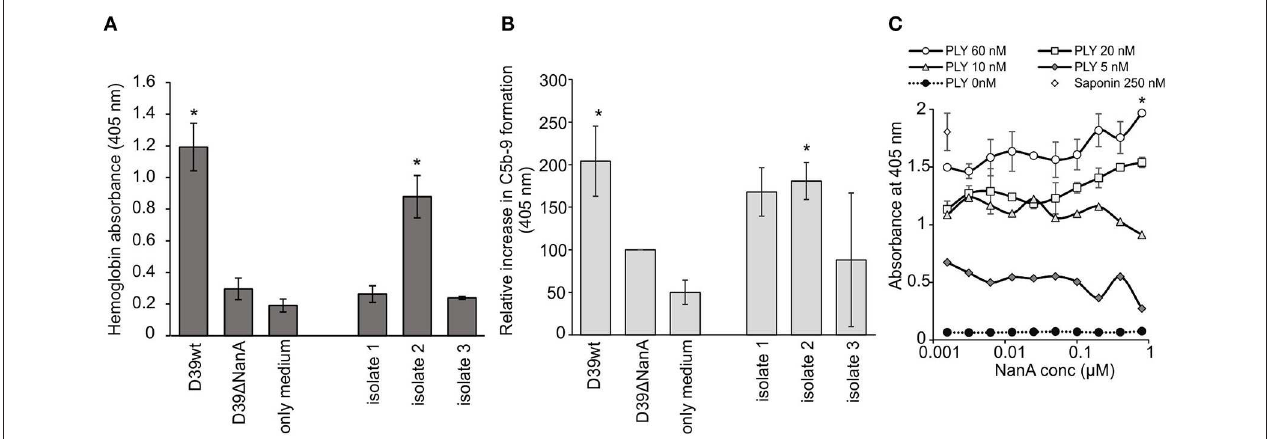
FIGURE 5 | Effect of S. pneumoniae NanA expression on complement-mediated red blood cell lysis. (A) Hirudin-anticoagulated whole blood was incubated for 1h at 37 ◦ C with the supernatants from S. pneumoniae D39 wild type (D39 wt), D39 nanA deletion mutant (D39 1 NanA) and three clinical isolates (isolates 1–3). Hemolysis was determined by measuring absorbance of hemoglobin at 405nm from the plasma ( n = 3). (B) Complement activation in whole blood was determined by measuring the formation of soluble SC5b-9 from blood isolated plasma by EIA (450nm) ( n = 3). All values are shown as a percentage of A450 values relative to D39 nanA mutant strain. Increase in SC5b-9 is calculated as relative absorbance against D39 1 NanA supernatant treated blood that was 0.500 ± 0.150 at 450nm in the isolated plasma. (C) Effect of NanA on hemolysis caused by pneumolysin (PLY). Red blood cells were incubated with increasing concentration of NanA compared with specific PLY concentration (0, 5, 10, 20, or 60nM). Hemolysis was detected by measuring absorbance of the supernatant at 405nm. Absorbances for different PLY concentrations (0–60nM) are shown ( n = 4). Saponin was used as a positive control and sample without PLY as negative control (0nM PLY) for red blood cell hemolysis. Statistical significances are calculated against (A,B) D39 1 NanA supernatant treated blood (C) or between the highes and lowest NanA concentration using one-way ANOVA (* P -value < 0.05). Error bars indicate SD.